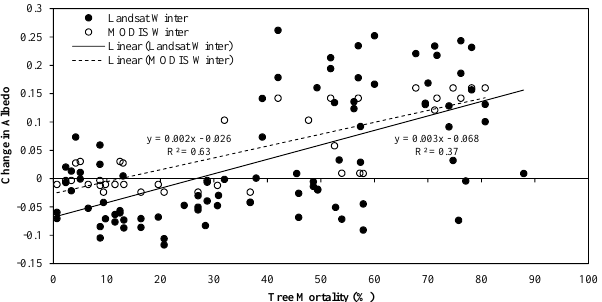
Fig. 4. Change in spring, summer and fall albedo with MPB out- break severity, defined as percent tree mortality, for outbreaks 4 to 13yr in age (gray attack stage). Linear regression lines shown for each